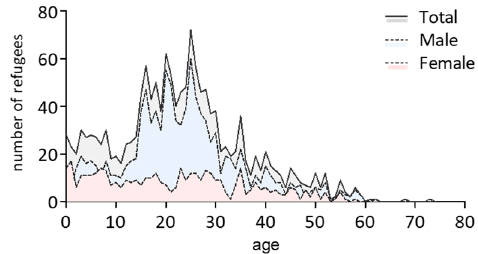
Figure 1. Age and gender distribution within the analyzed cohort.